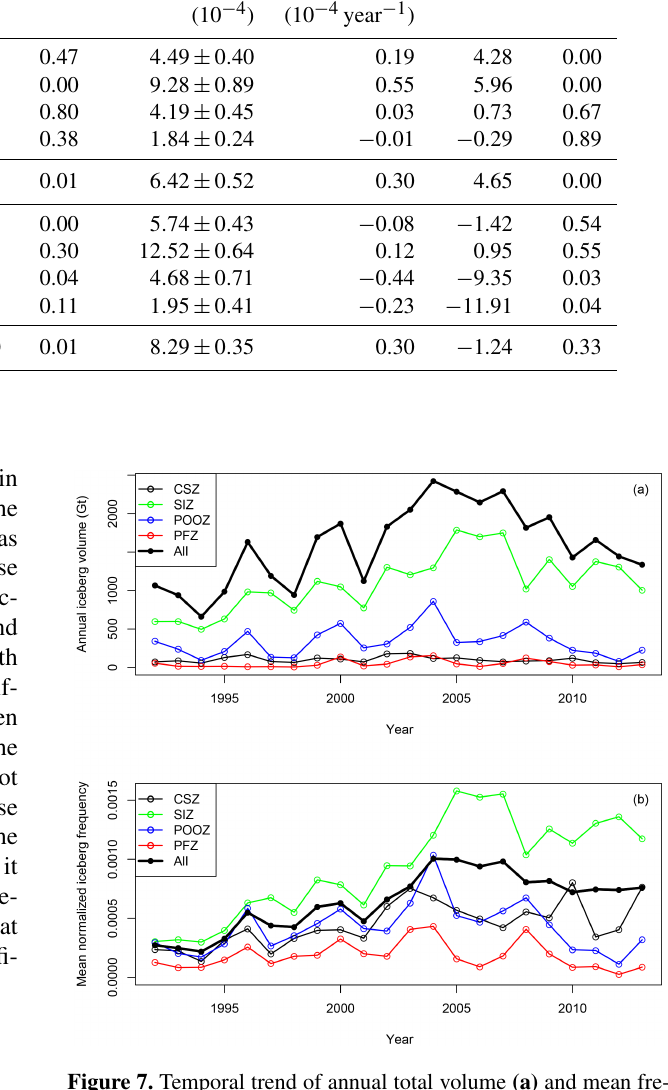
Table 5. Temporal trend of annual volume and frequency of small icebergs by ecological zones. Time Zone Iceberg volume Normalized iceberg frequency Rate of p ∗ Rate of mean change change value mean change change